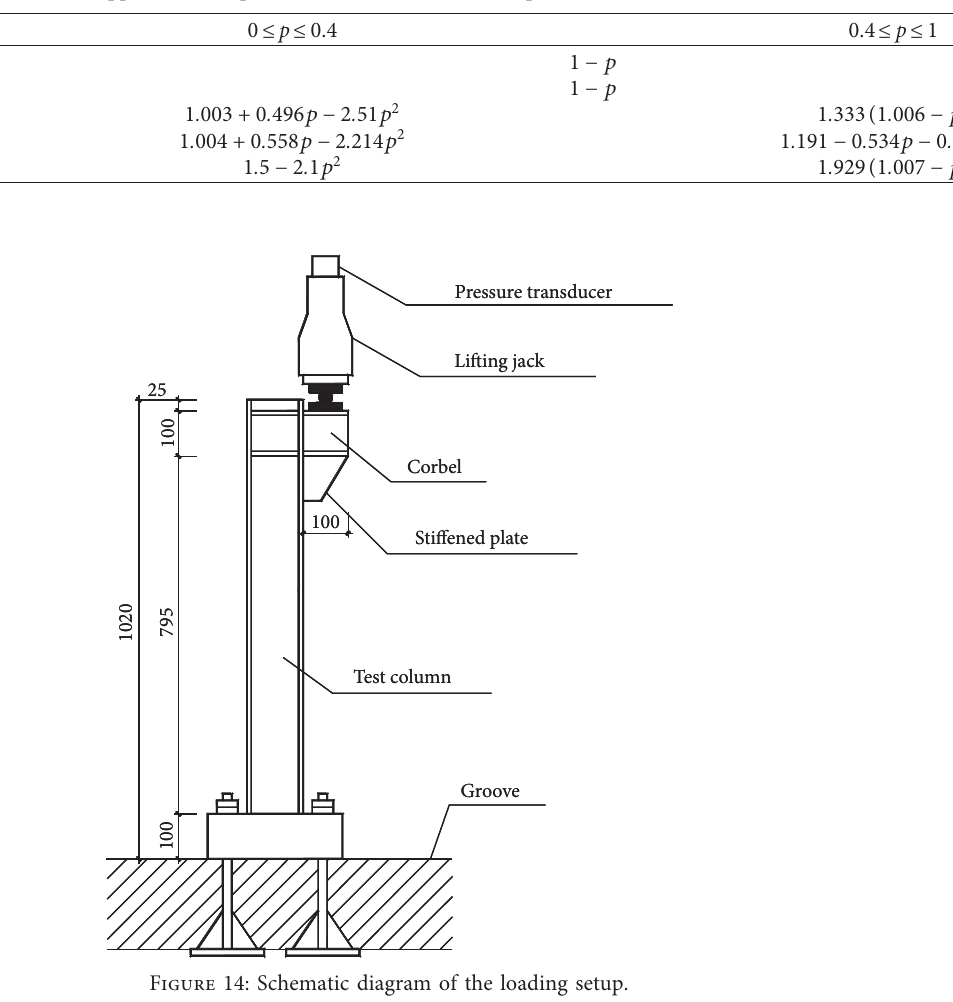
Table 4: Approximate expressions of M- Φ -P relationship of steel column sections.